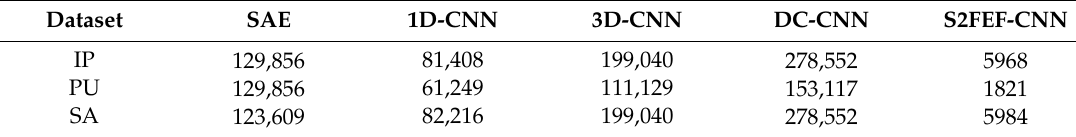
Table 3. The total parameters of the di ff erent networks on di ff erent datasets.